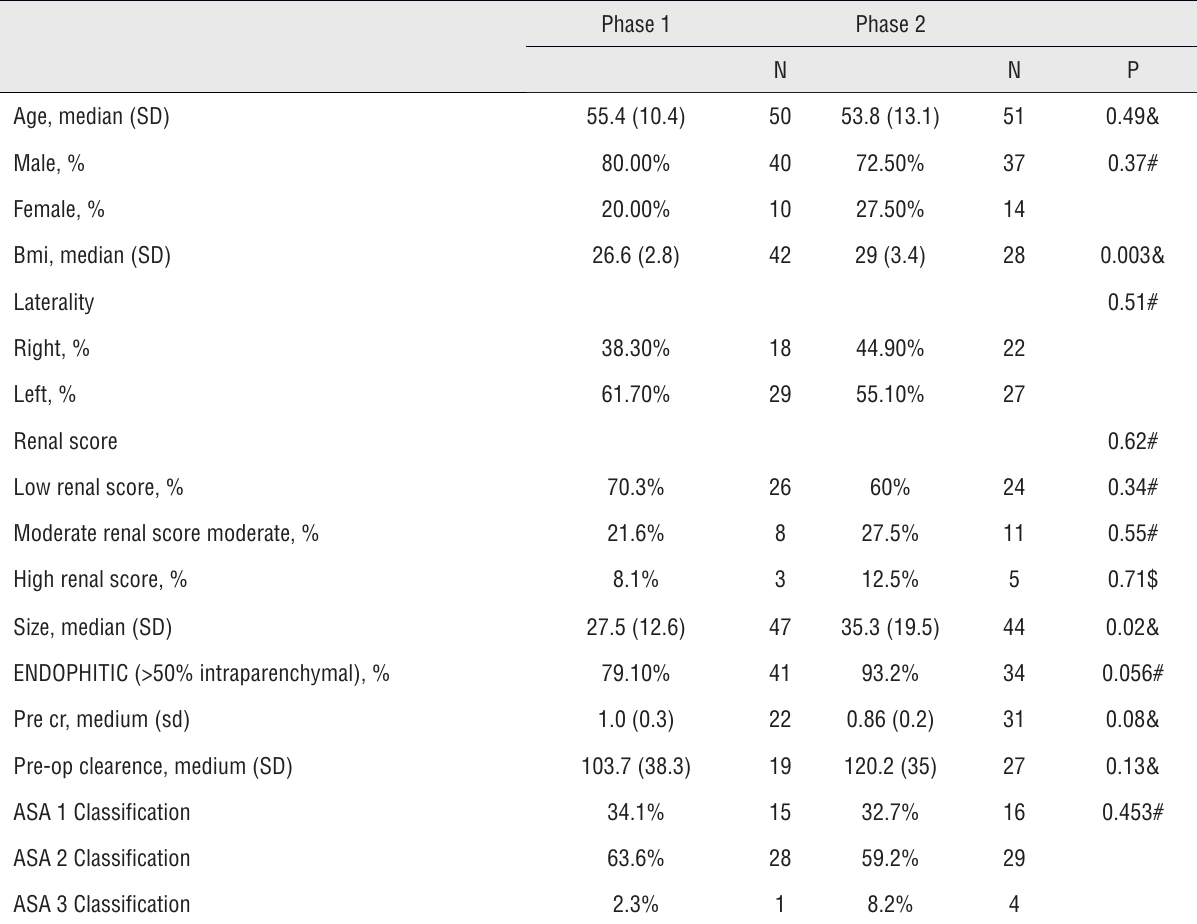
Table 1 - Demographic data.